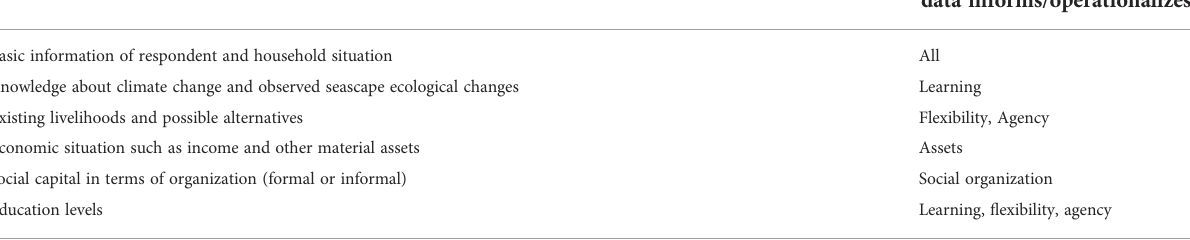
TABLE 1 Themes for discussion during the semi-structured interviews with coastal women (N= 117) in six villages in Zanzibar to gather information about their adaptive capacity. Themes/Topics that were discussed with each coastal woman during the